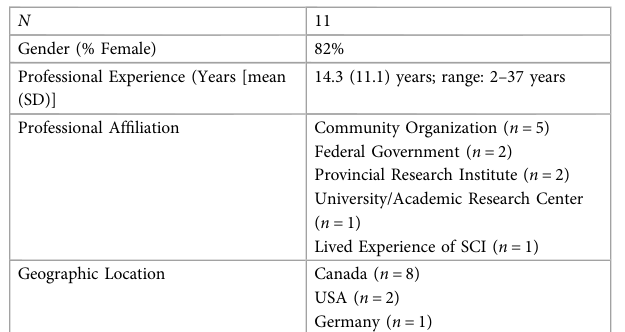
TABLE 3 Characteristics of